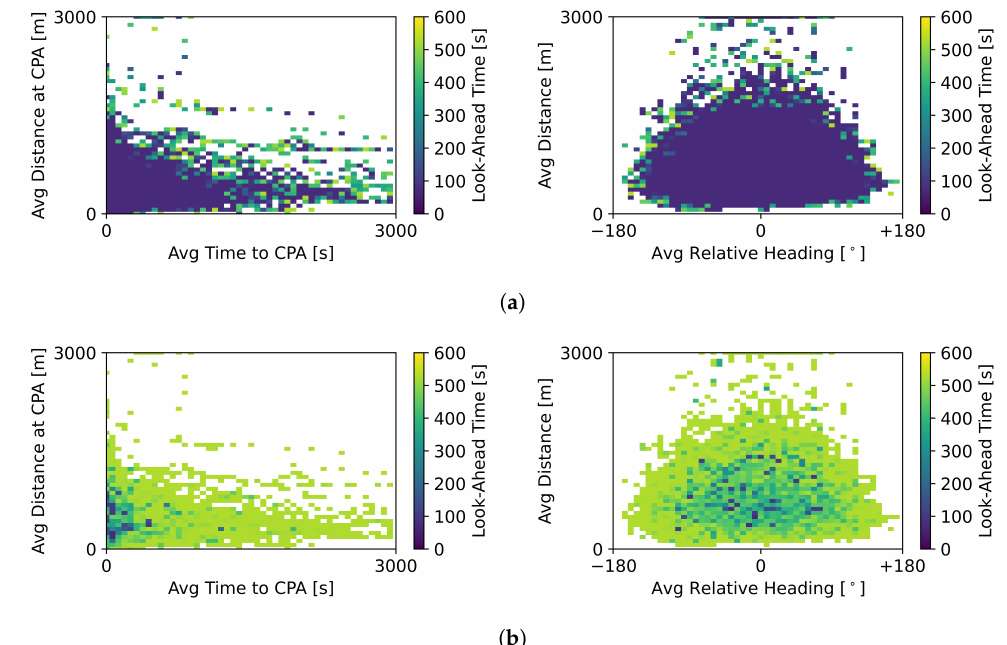
Figure 8. Different look-ahead time values employed by the hybrid RL + MVP method. ( a ) Look- ahead time values employed by the RL method (H + S) when heading, speed, and altitude variations were used to resolve conflicts. ( b ) Look-ahead time values employed by the RL method (H + S) when only heading and horizontal speed variations were used to resolve